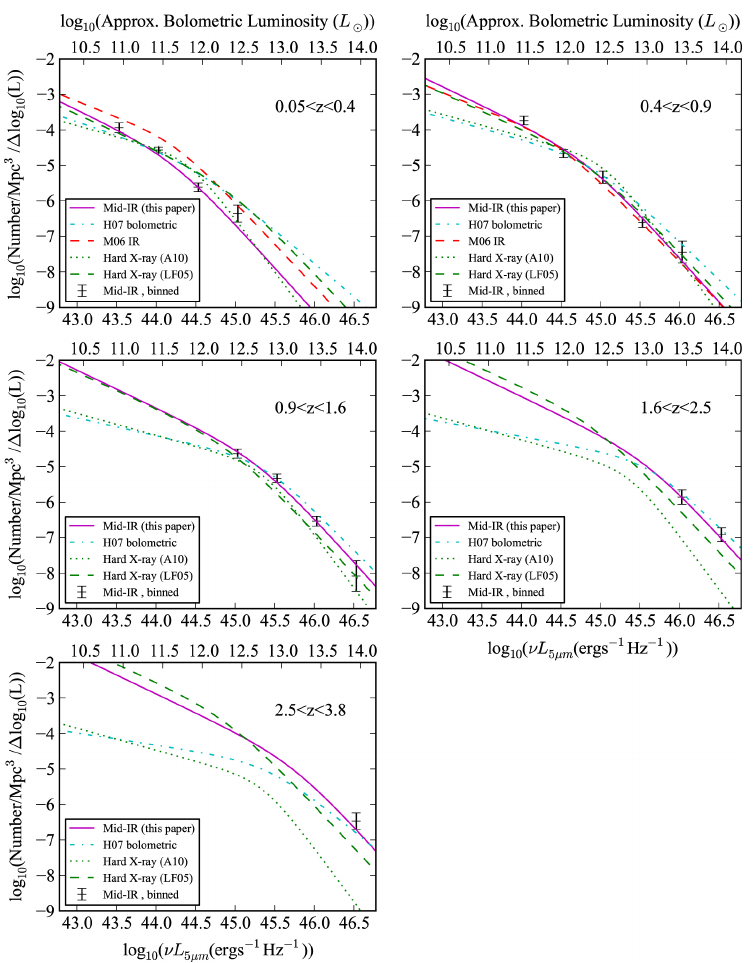
Figure 6. Luminosity functions of mid-IR selected (and spectroscopically confirmed) AGN compared with estimated bolometric luminosity functions (H07; [104]) and luminosity functions based hard X-ray selected AGN (LF05; [105]) and (A10; [106]). More recent results on the mid-IR AGN LF are consistent with these at the high-L end, but show somewhat less steep slopes in the low-L regime [19]. Adapted from Lacy et al. [101], © AAS. Reproduced with